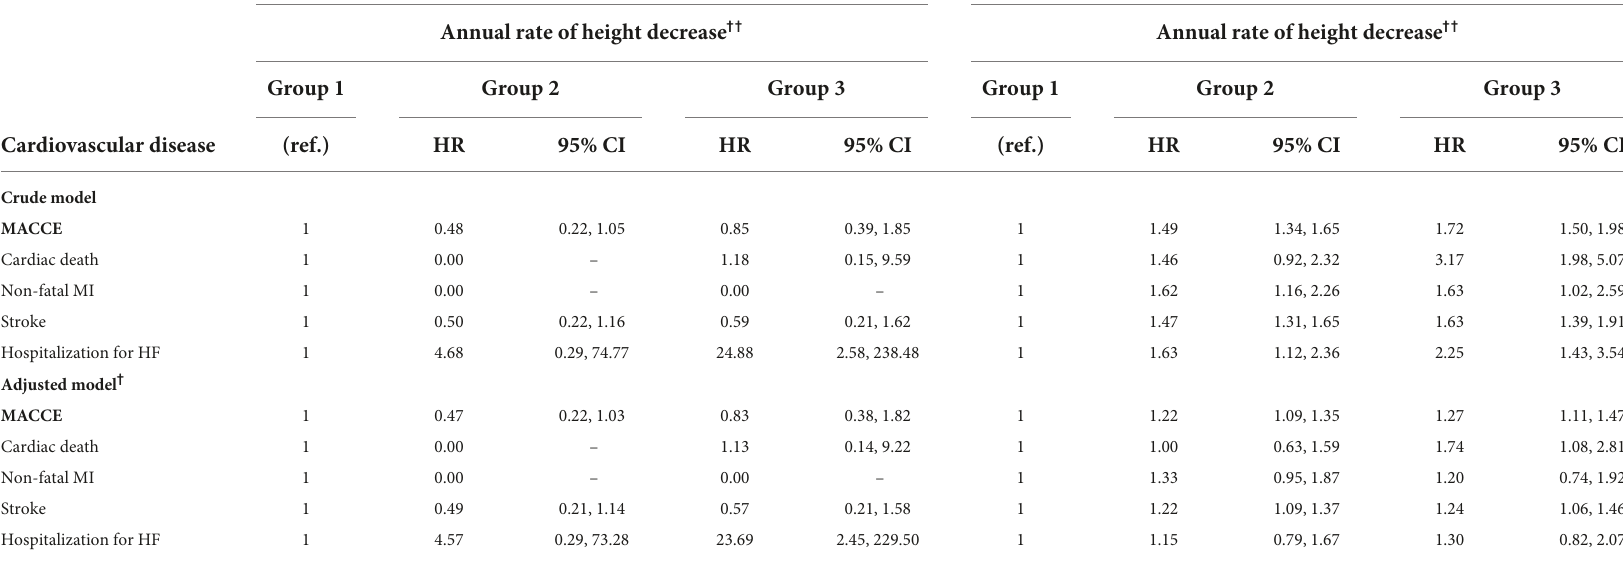
TABLE 7 The hazard ratios of major adverse cardiovascular and cerebral events per the annual height decrease rate in female patients based on menopausal status. No Yes Annual rate of height decrease †††††† Annual rate of height decrease ††††††